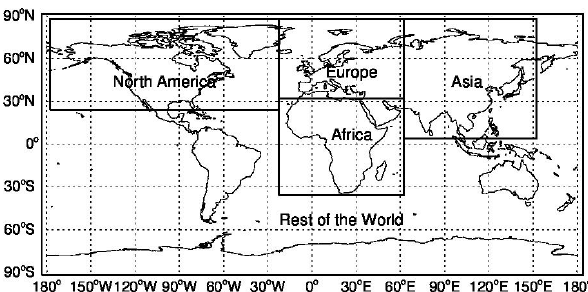
Figure 2. Tropospheric O 3 source regions for tagged O 3 simula-